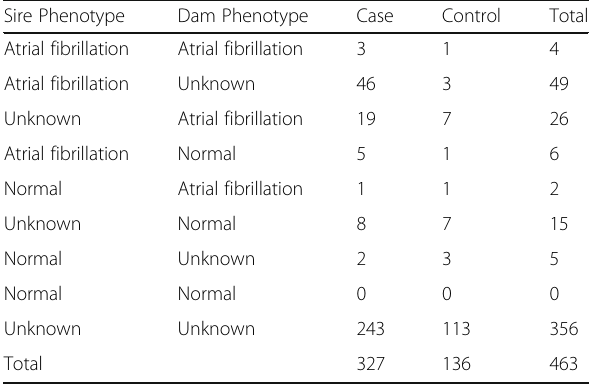
Table 1 Distribution of parent phenotypes for Irish Wolfhounds with atrial fibrillation or without atrial